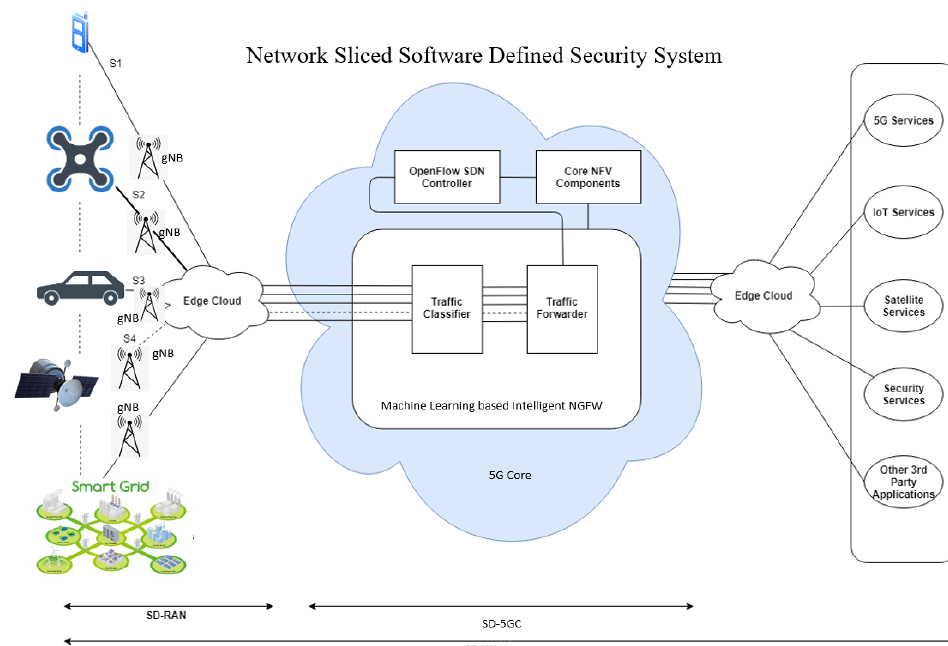
Figure 7. End-to-end model describing slice-based software defined security.